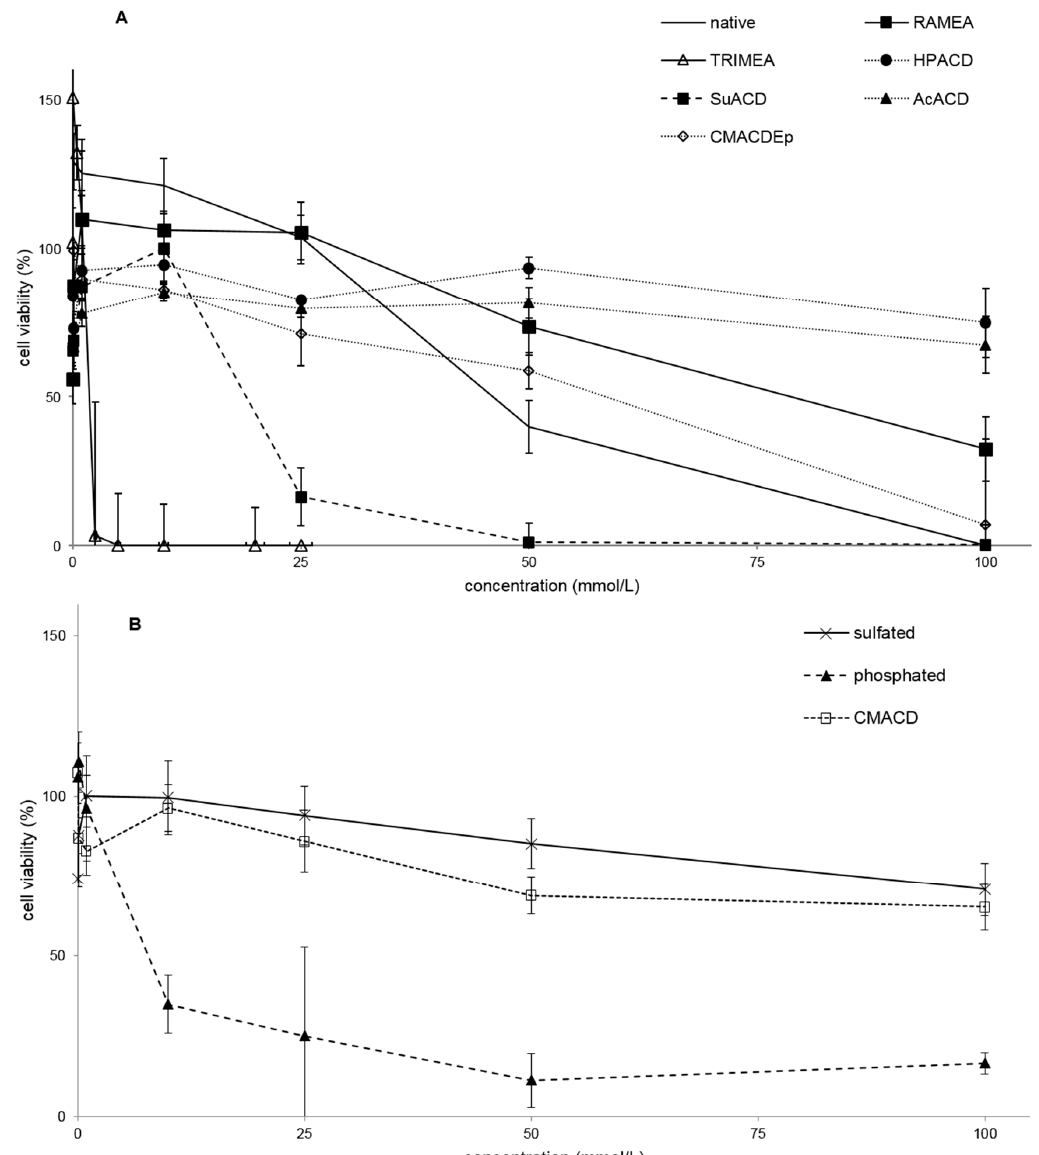
Figure 2. Effect of non-ionic ( A ) and ionic ( B ) α -CD derivatives on Caco-2 cell viability, determined by MTT-test. Cell viability was expressed as the percentage of untreated control in the function of α -CD derivatives concentration. Phosphate buffered saline (PBS) served as negative control and Triton X 100 (10% w / v ) as positive control. Values presented are means ± SD. All data were obtained from three to five independent biological replicates and in the same experiments four parallel concentrations were measured.